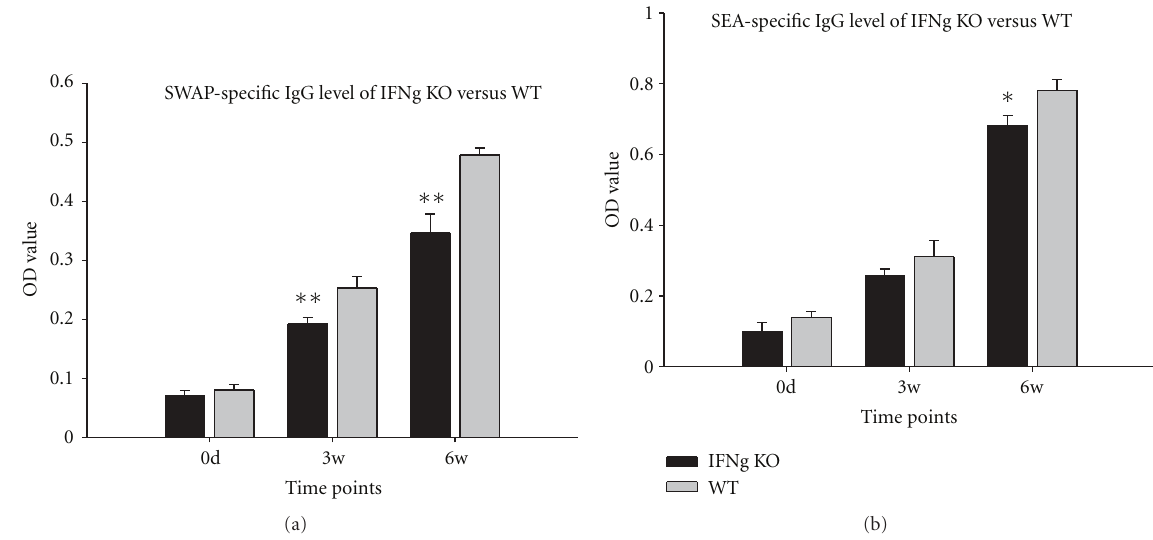
Figure 2: Dynamics of SWAP- and SEA-specific IgG antibody levels in IFNg KO and WT mice ( n = 10, resp.) according to ELISA of sera harvested at day 0, 3 weeks, and 6 weeks after-infection (compared with WT mice, ∗ P < 0 . 05, ∗∗ P < 0 . 01). Data are representative of two independent experiments with the similar results.